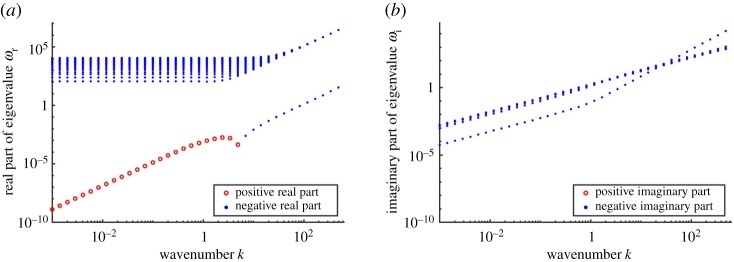
Plot of the eigenspectra over a range of k for the top 20 eigenvalues with the largest real parts. θ = 0.01, Re = 20, L = 10−3, α = 10−3. The eigenvalue that visually stands out in magnitude for each k corresponds to the sediment transport eigenvalue. (a) Real part of eigenvalue and (b) imaginary part of eigenvalue. (Online version in colour.)